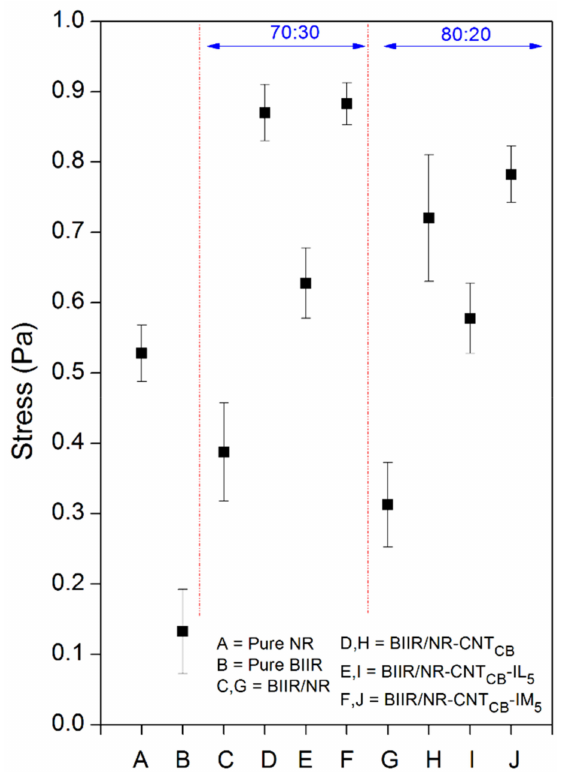
Figure 12. Puncture stress of pure rubbers and their composites with and without IL and IM modifiers, BIIR:NR ratios of 70:30 and